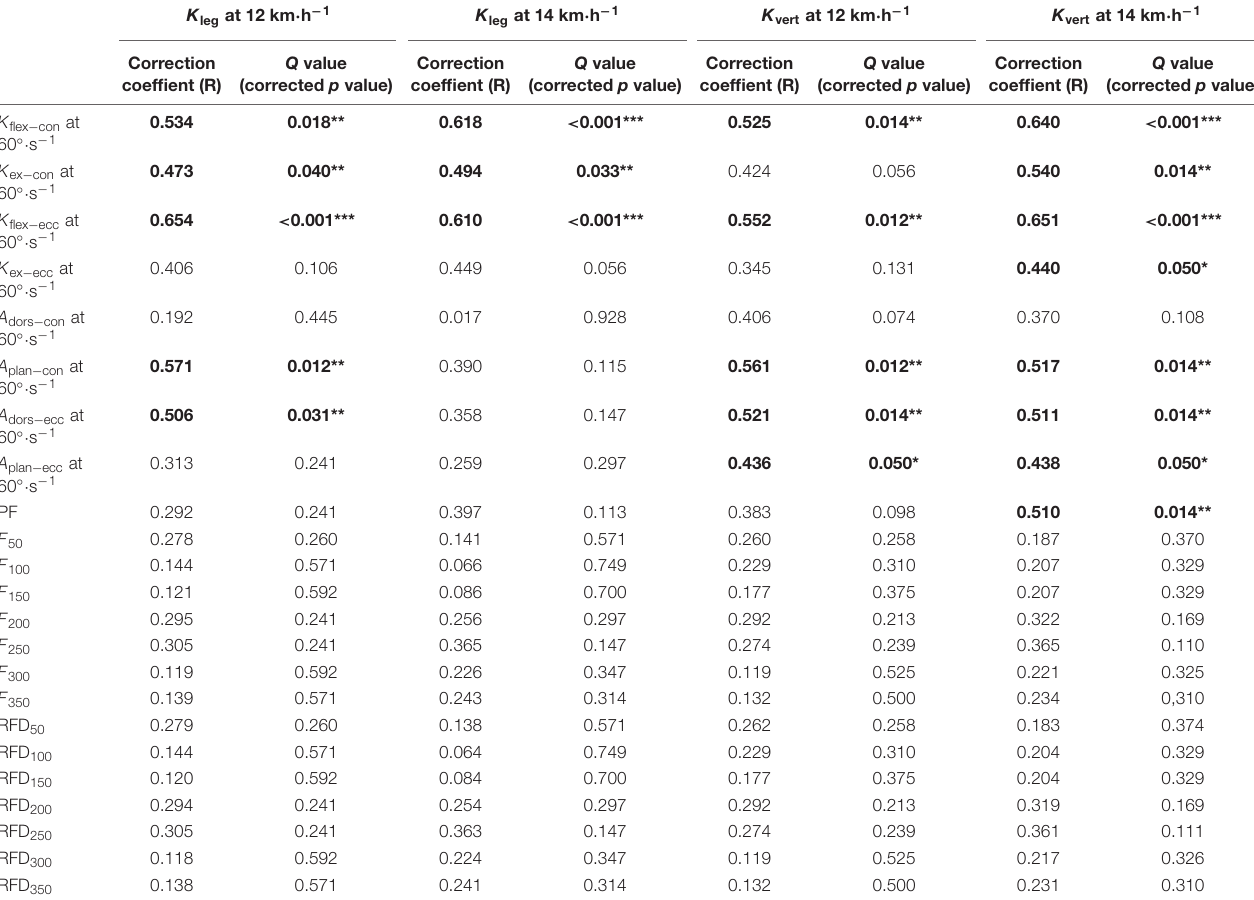
TABLE 2 | Correlations between Neuromuscular characteristics and leg-spring stiffness at running speed of 12 and 14 km · h − 1 ( n = 31). K leg at 12 km · h −